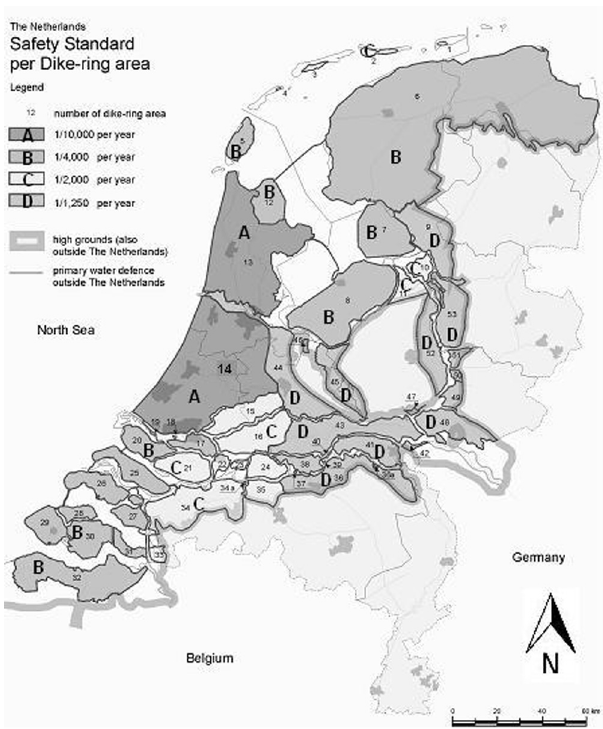
Fig. 3. Safety standards of dike-ring areas in the Netherlands. The letters A to D are used to indicate the safety standards between 1 / 10000 per year and 1 / 1250 per year. Source: TAW